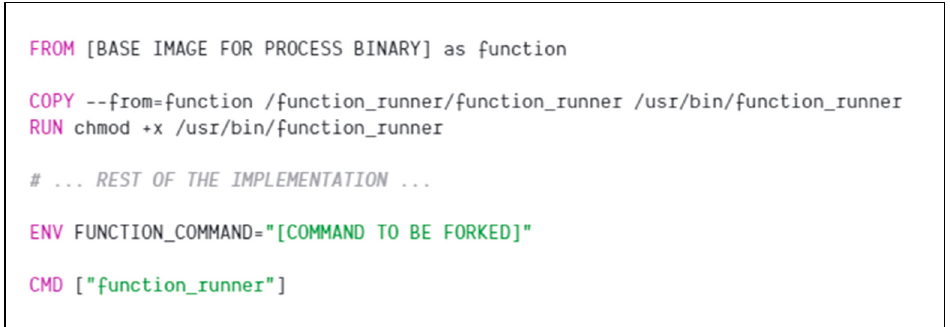
Figure 10. An example docker file content that uses the base image contains the agent.